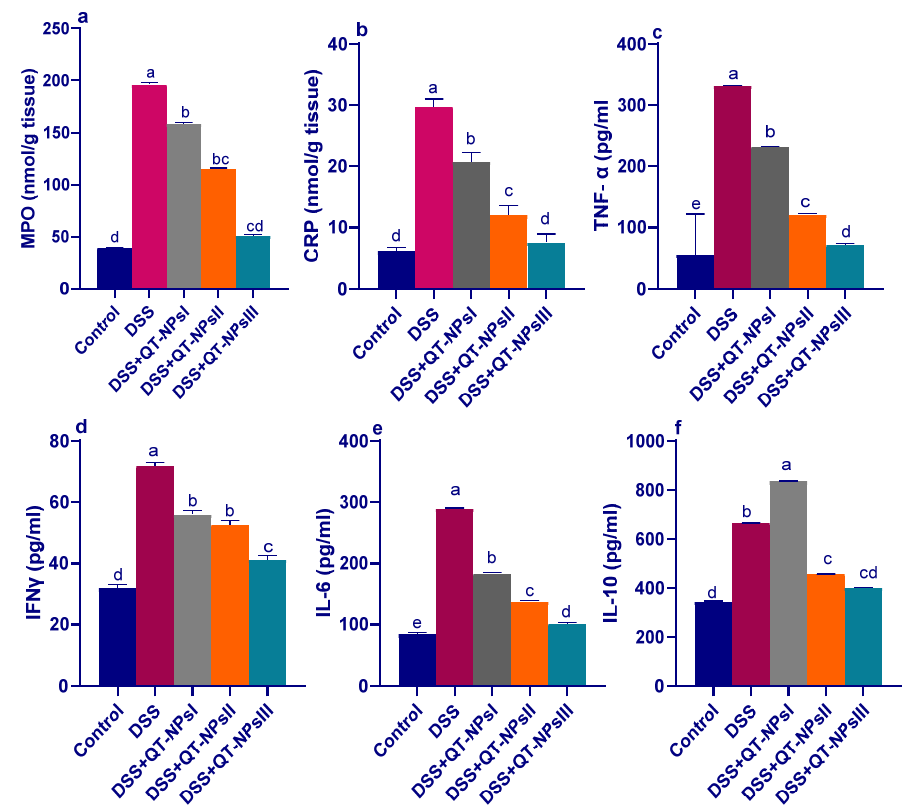
Figure 6. Impacts of quercetin-loaded nanoparticles (QT-NPs) therapy on MPO: myeloperoxidase ( a ), CRP: C-reactive protein ( b ), TNF- α : tumor necrosis factor alpha ( c ), IFN γ : Interferon gamma ( d ), IL-6 and IL-10: interleukin ( e , f ) 14 days post DSS induction. Mean values with different letters in the same row differ significantly at p < 0.05, SE: standard error. a–e Means of the rows with different letters were significantly different among groups ( p < 0.05). Control: healthy non-colitic group (rats orally gavaged with PBS). Colitic groups: DSS (rats orally gavaged with dextran sodium sulphate), DSS + QT-NPsI (rats orally gavaged with DSS and quercetin-loaded nanoparticles (QT-NPs at the level 10 mg/kg body weight for 14 days)), DSS + QT-NPsII (rats orally gavaged with DSS and quercetin-loaded nanoparticles (QT-NPs at the level 15 mg/kg body weight for 14 days)), and DSS + QT-NPsIII (rats orally gavaged with DSS and quercetin-loaded nanoparticles (QT-NPs at the level 20 mg/kg body weight for 14 days)). All groups orally gavaged by 3% DSS.